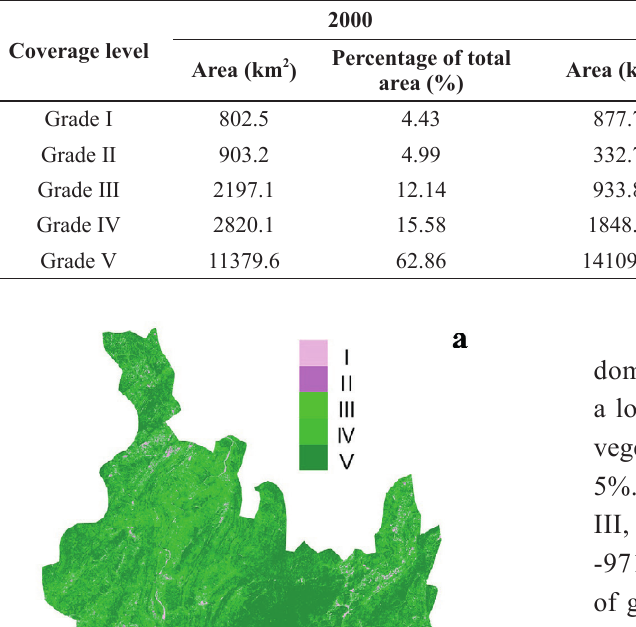
Vegetation coverage statistics for 2000 and 2016.